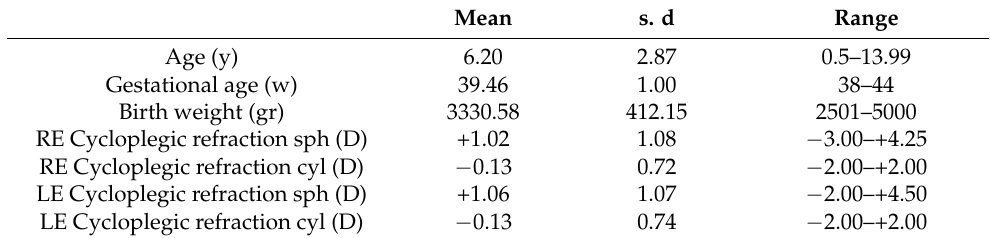
Table 1. Norm group results.